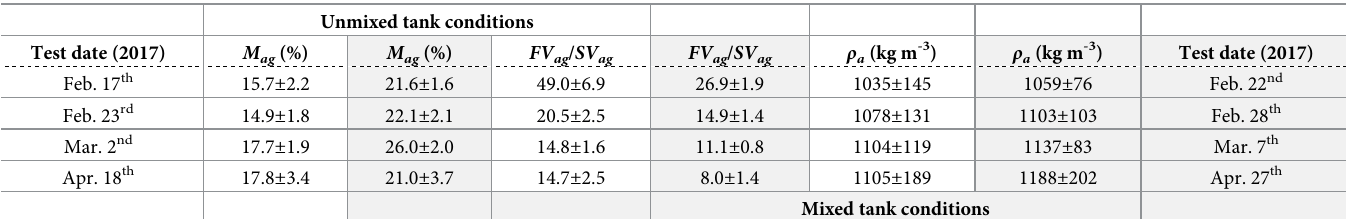
Table 4. Floc population characteristics for the unmixed (left, white) and mixed (right, grey) aggregation tank